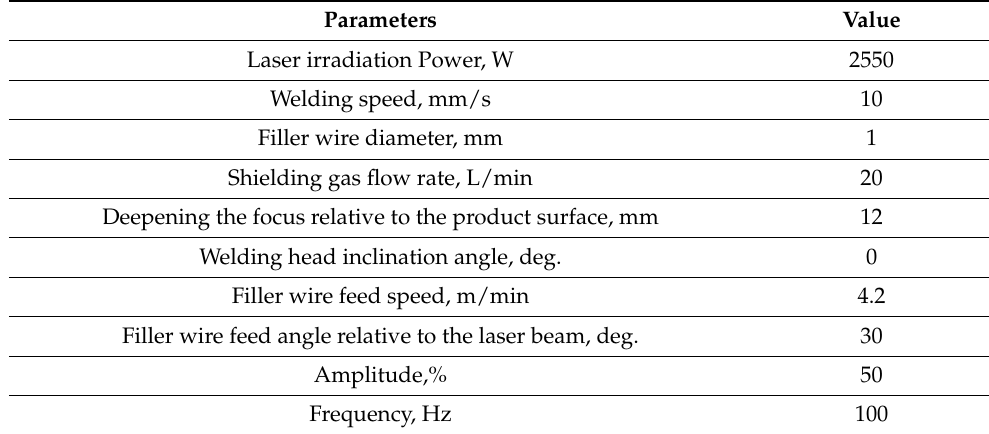
Table 4. Parameters of the optimal mode of laser cladding with filler